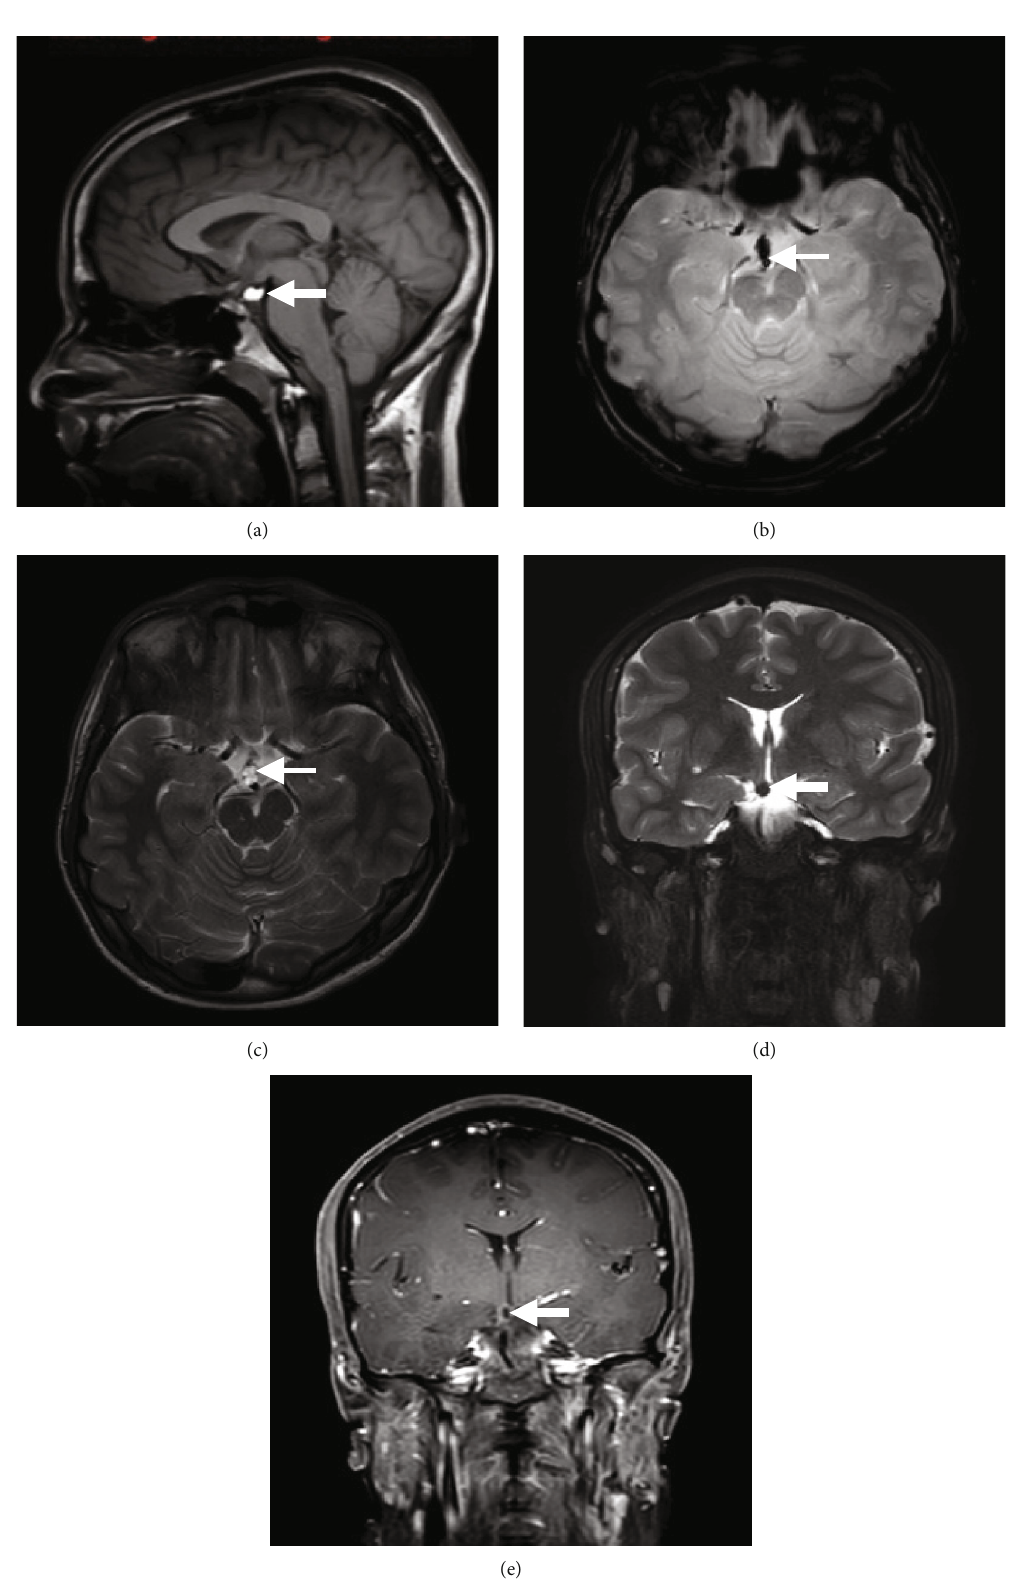
Figure 3: (a) Sagittal T1-weighted MRI. (b) Axial T2-gradient MRI. (c) Axial T1-weighted MRI. (d) Coronal T2-weighted MRI. (e) Coronal T1-weighted MRI with contrast. (a) – (e) The images are demonstrating a well-de fi ned hypothalamic lesion following fat signal on all sequences. Faint peripheral enhancement is noted after contrast